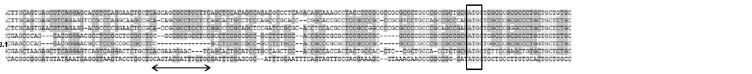
Fig 2. Alignment of DNA sequences upstream of the ATG of the Cox-2 gene from Human, Horse, Cow, Wolf, CanFam3.1 assembly, Mouse and Chicken. The presumed translation initiation ATG is boxed. A DNA variant (deletion of 12 nucleotides) is observed in CanFam3.1 sequence when compared to other organisms (double headed